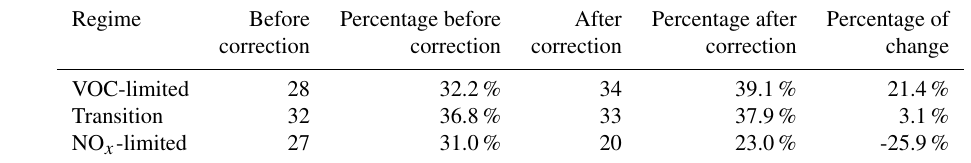
Table 1. Variations in the number and proportions of months in 2010–2019 for each regime before and after the correction.